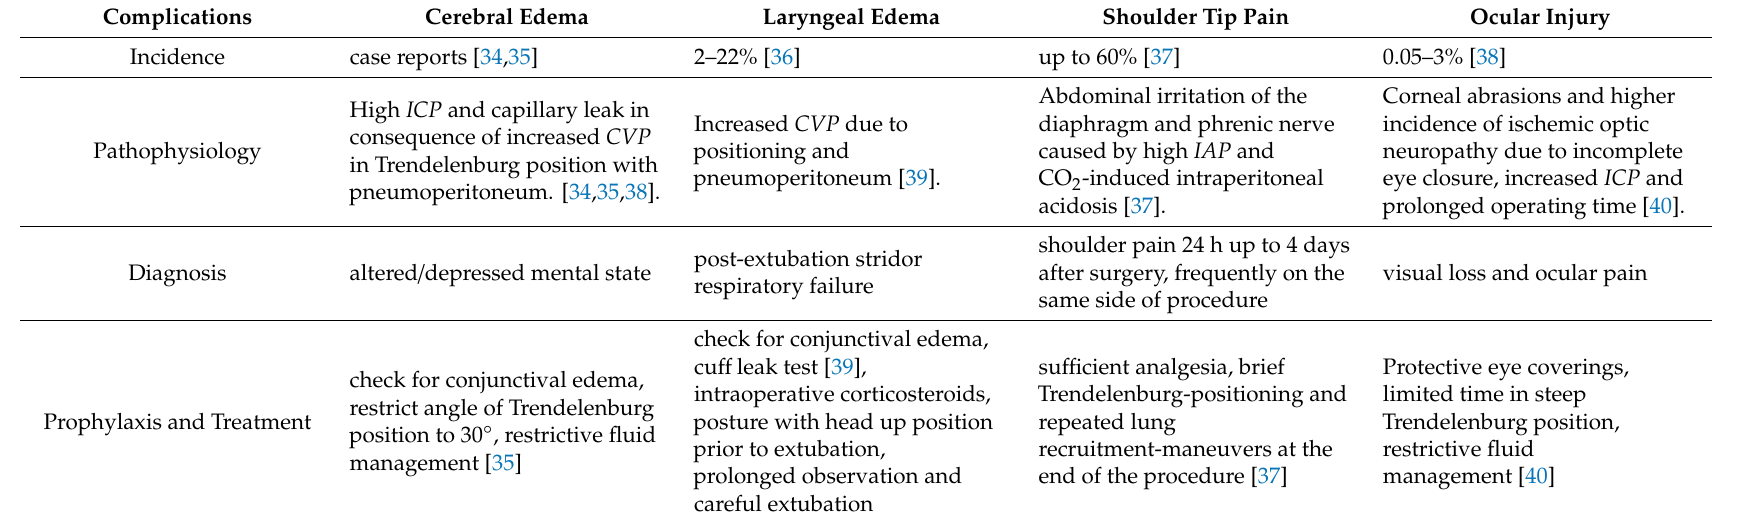
Table 3. Postoperative complications of laparoscopic and robotic